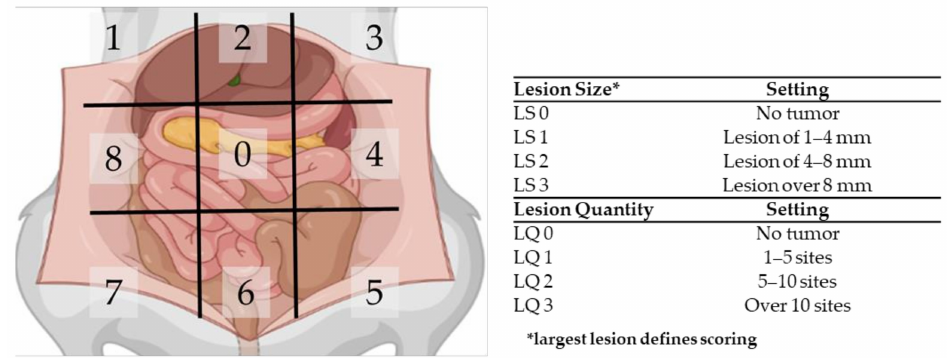
Figure 3. Schematic overview of the peritoneal cancer index (PCI) tool to assess the extent of PM in